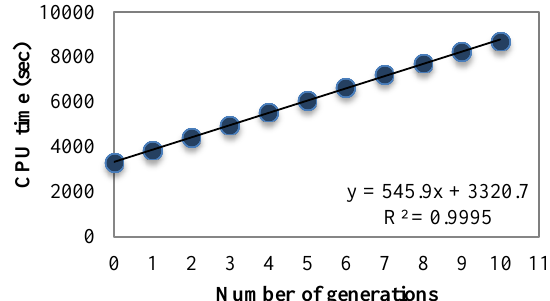
Figure 17. Relationship between the number of generations (1- 10) and the average CPU